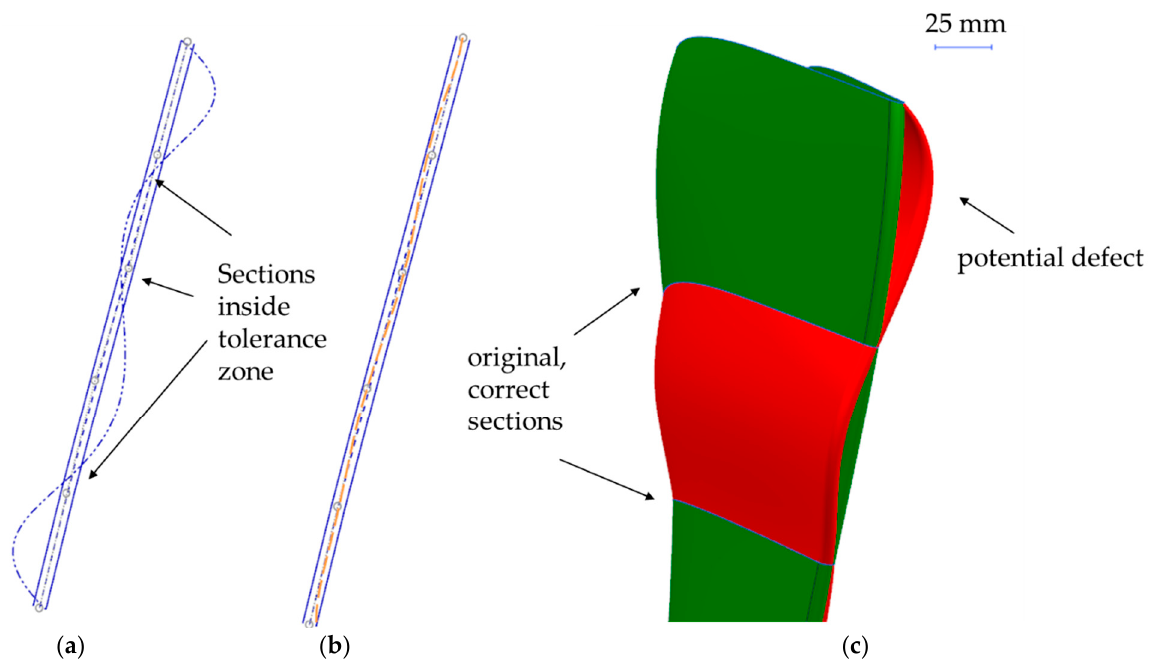
Figure 5. ( a ) Potential error for sections measured separately; ( b ) trend line within the tolerance to assure all measured and not measured sections lie in the correct position; ( c ) potential defect in 3D.